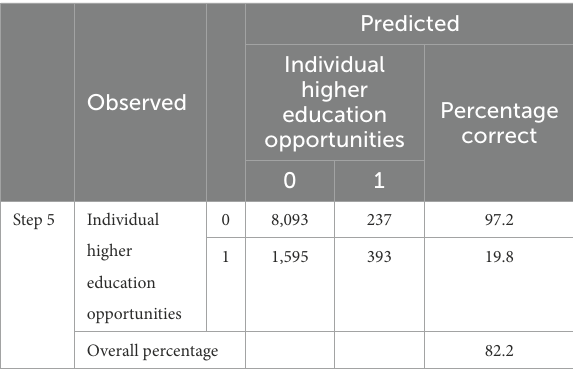
TABLE 4 Final prediction classification table (Forward: LR).